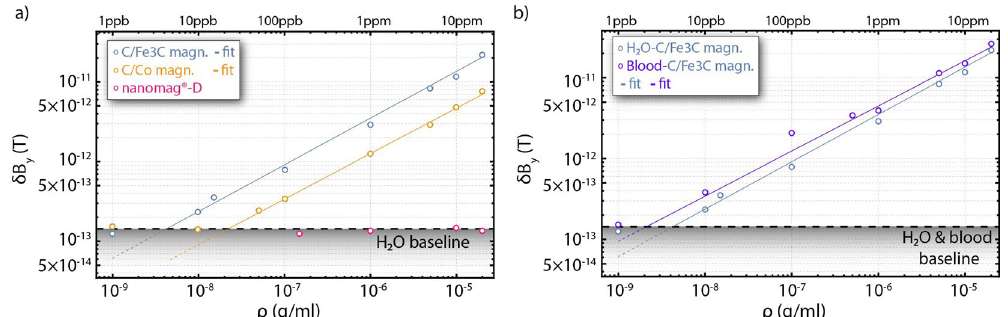
Figure 3. ( a ) Magnetic field variance signal for different concentrations of the C/Fe 3 C, C/Co and nanomag-D nanoparticles, under pre-magnetized conditions, in water solutions. ( b ) Comparison of the magnetic field variance signal between water and blood solutions for different concentrations of the C/Fe 3 C nanoparticles under pre-magnetized conditions. All measurements are realized under constant flow conditions (10 ml/ min). The black dashed lines [( a , b )] represent the baseline for each measurement, obtained for measurements performed with pure water or blood. The solid lines represent fits to the experimental